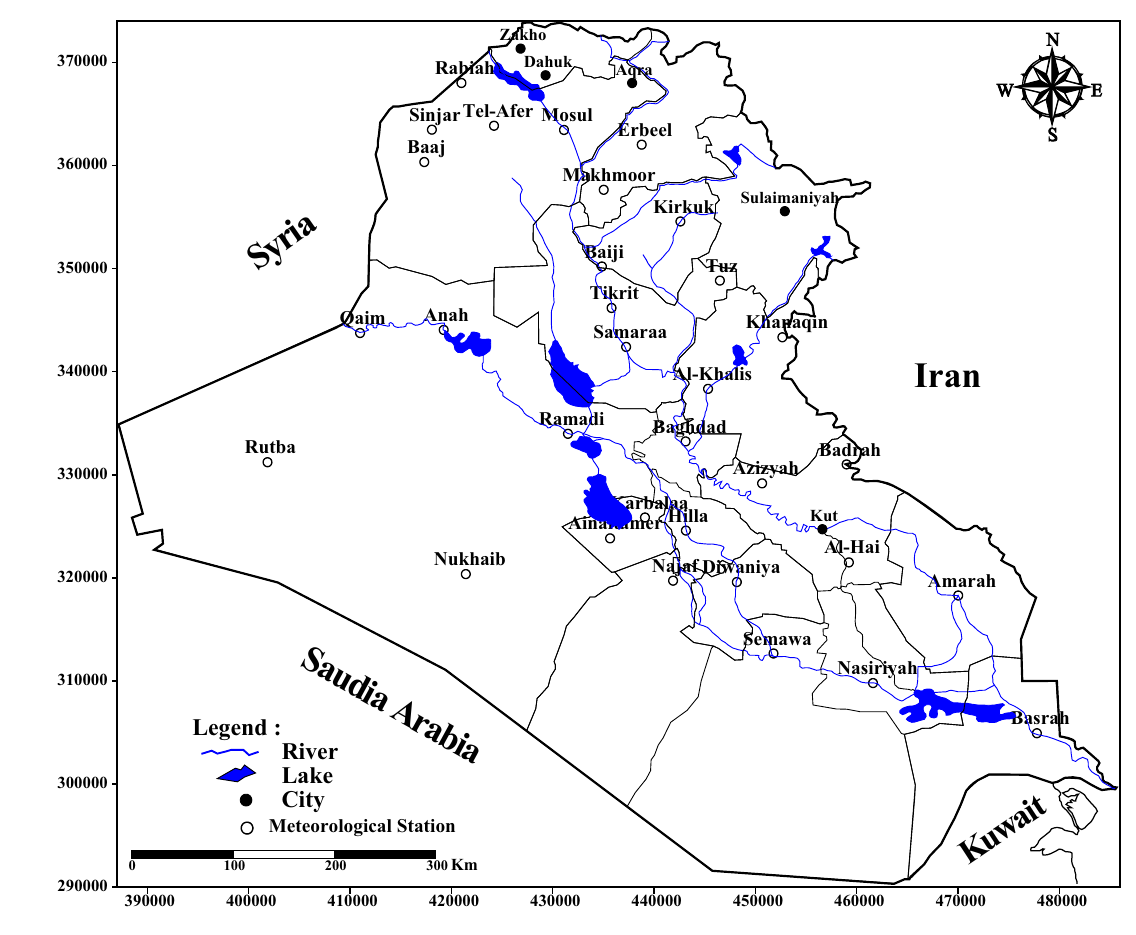
Fig. 1 Distribution map of meteorological stations in